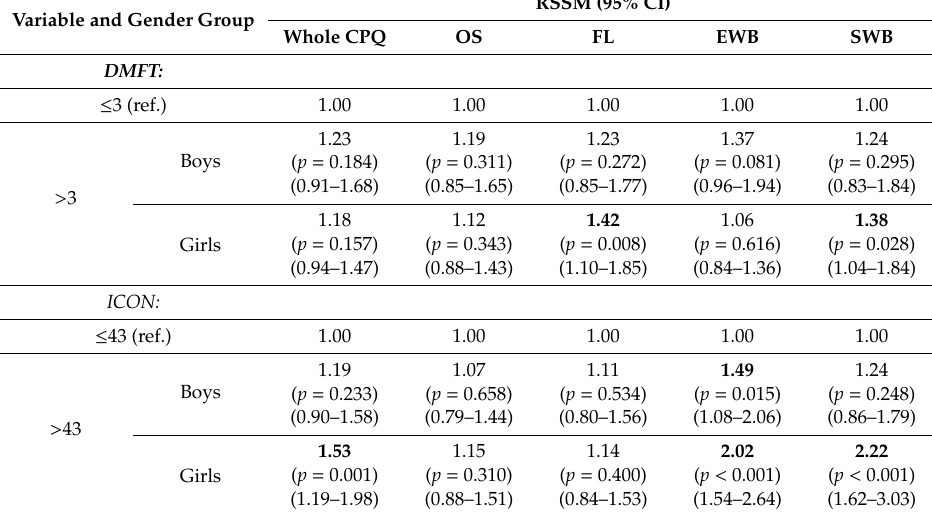
Table 4. Relationship between clinical characteristics of oral health and CPQ sum score by gender: results of the multivariate NBR analysis adjusting data for age and family a ffl uence ( N = 600). Variable and Gender Group